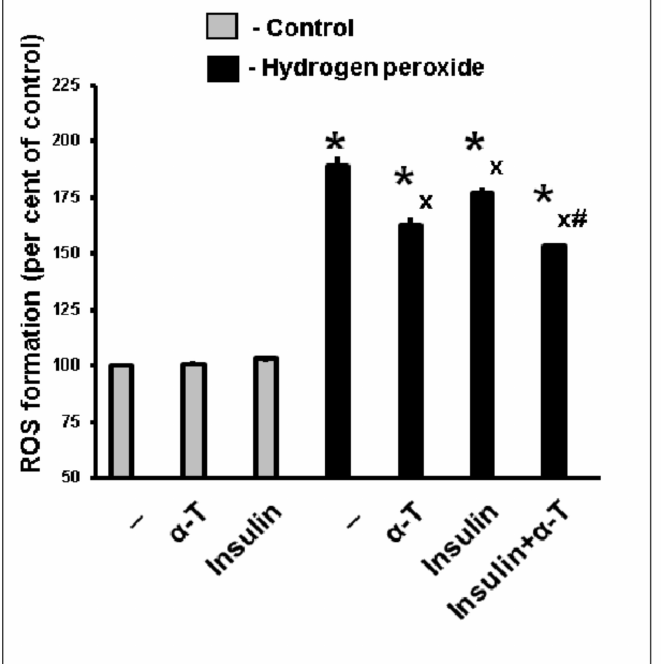
Figure 3. The pre-incubation with insulin or α -T or with both drugs diminishes the formation of ROS in brain cortical neurons exposed to hydrogen peroxide. The data of one typical experiment from five experiments made are given as the means ± SEM. Cortical neurons were pre-incubated for 1 h with 1 µ M insulin or for 18 h with 50 µ M α -T or with both drugs or without them. Then the neurons were exposed to 100 µ M hydrogen peroxide for 1 h. The differences are significant according to Student’s t -test as compared to: *—control, x—the effect of hydrogen peroxide alone, #—the effect of either insulin or α -T alone, p < 0.05 in all